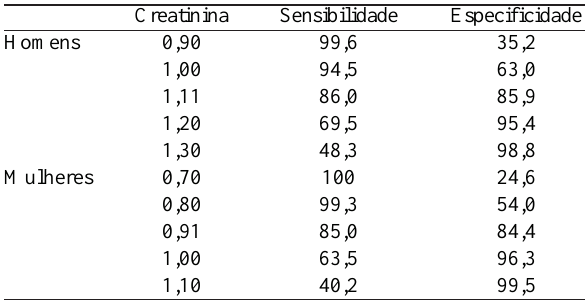
Tabela 2. Sensibilidade e especificidade (%) da creatinina sérica para detectar DCEe < 60mL/min/1,73m²